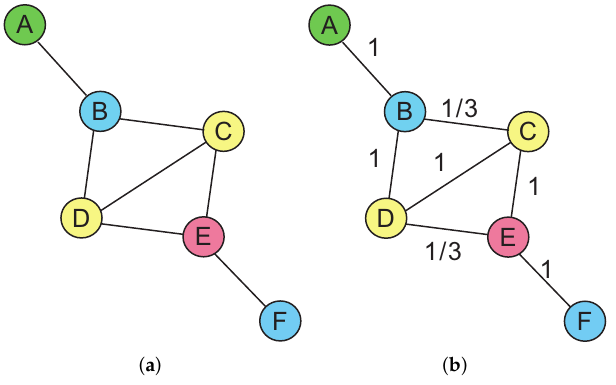
Figure 3. Illustration of routing with network coding. ( a ) Network with the same transmission success rate links; ( b ) Network with different transmission success rate